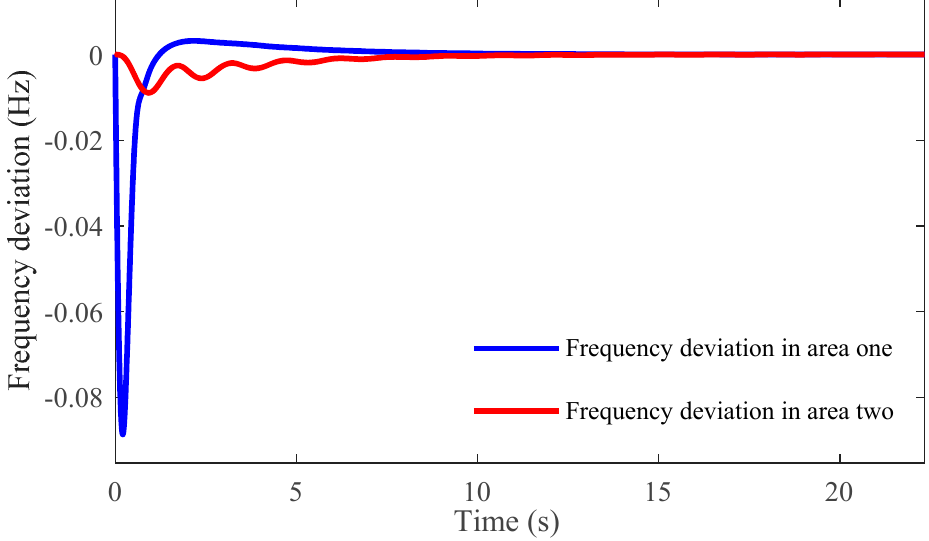
Figure 8. Frequency variation in area one and area two under parametric uncertainty conditions with the proposed FC FOPI-FOPD controller.